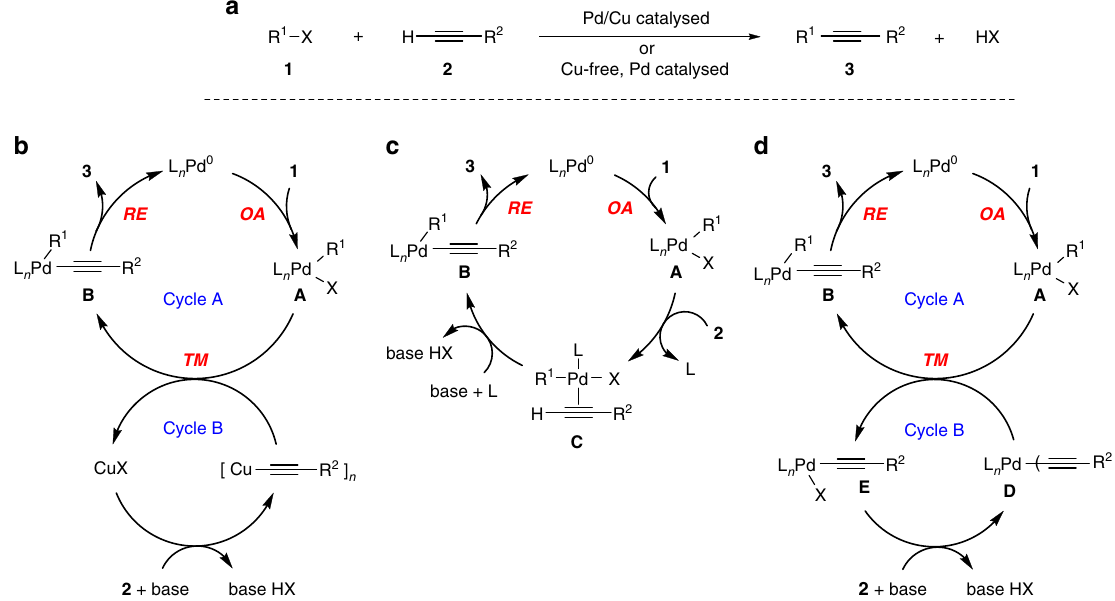
Fig. 1 The Sonogashira reaction. a General representation of Pd/Cu catalysed and Cu-free Sonogashira reaction. b Textbook mechanism for the Pd/Cu catalysed Sonogashira cross-coupling reaction that is synergistically catalysed by Pd and Cu. c Textbook mechanism for Cu-free Sonogashira reaction. d Our mechanistic proposal for Cu-free Sonogashira reaction. OA oxidative addition, TM transmetallation, RE reductive elimination ( cis – trans isomerization steps are omitted for ( trans - B and trans - E , respectively), while complex 6 serves as trans - D delivering acetylene to 4 in the transmetallation step. To